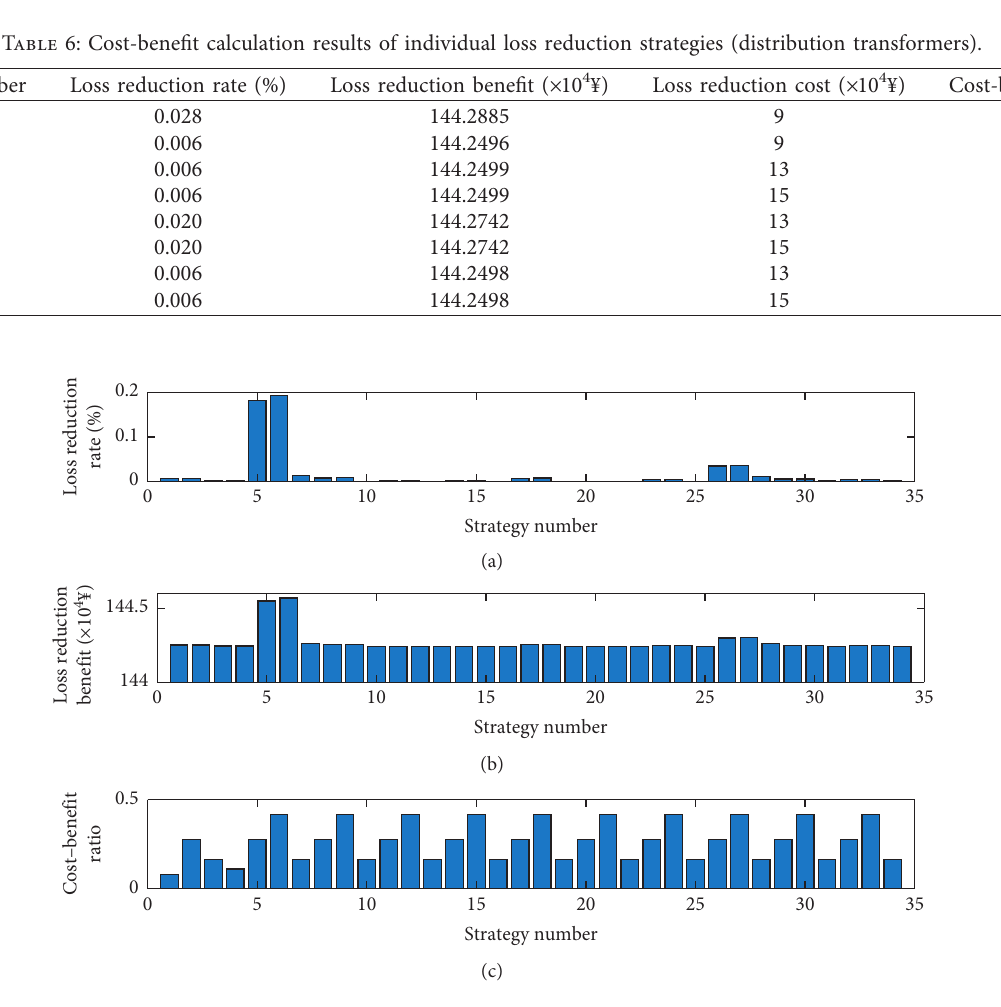
Figure 8: Cost-benefit calculation results of individual loss reduction strategies (distribution